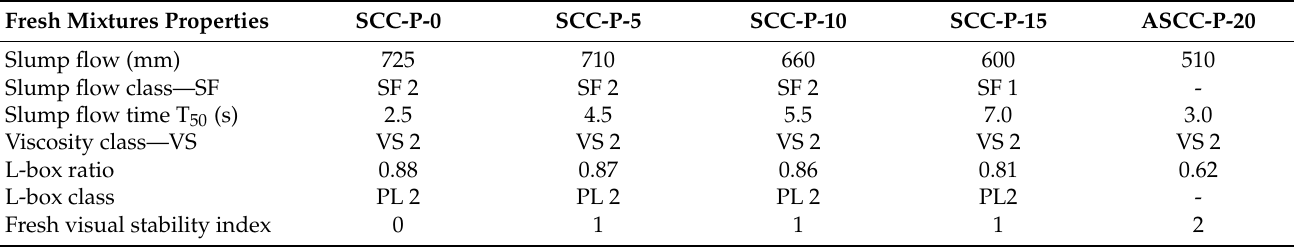
Table 5. Properties of the fresh SCC